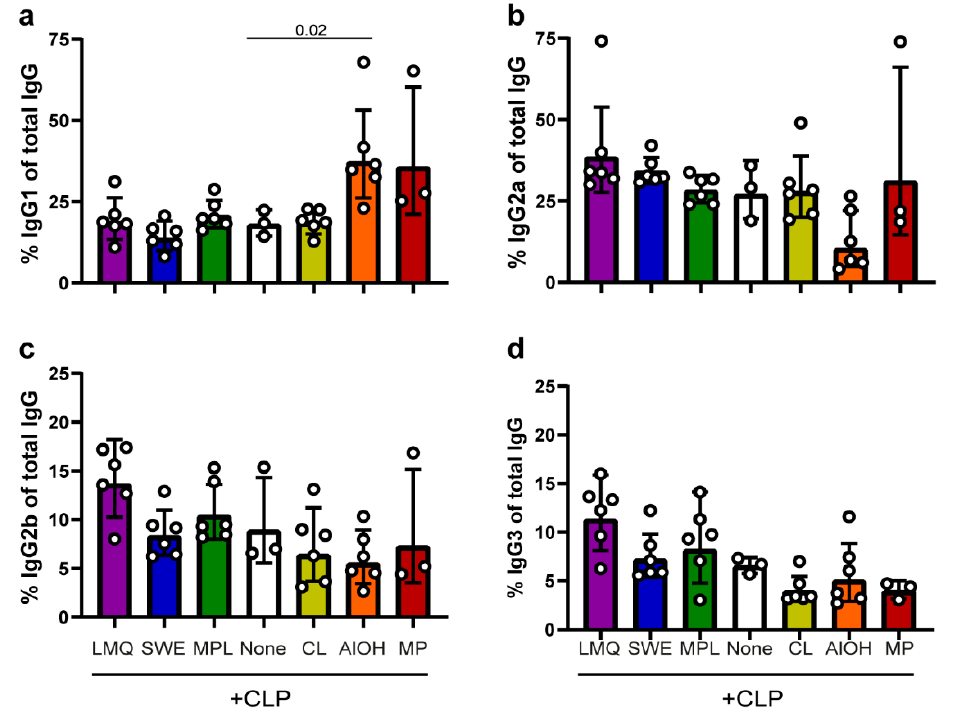
Figure 3. Characterization of vaccine-induced IgG subclasses. To characterize the IgG responses induced by the SpyCatcher-AP205-L2 vaccine formulated in the different extrinsic adjuvants, the relative proportions of IgG subclasses were normalized against the total vaccine-induced IgG. The four panels show the relative amounts of IgG1 ( a ), IgG2a ( b ), IgG2b ( c ) and IgG3 ( d ). The geometric mean is displayed along with the geometric standard deviation (SD). Kruskal–Wallis test showed that there was significant differences between two or more groups ((a) p = 0.0016, (b) p = 0.0085, (c) p = 0.0380, and (d) p = 0.0052). Hereafter, uncorrected, pairwise Mann–Whitney analysis was conducted to assess statistically significant differences between each of the different adjuvant groups and the un-adjuvanted group (none). Significant differences are indicated in the graph.